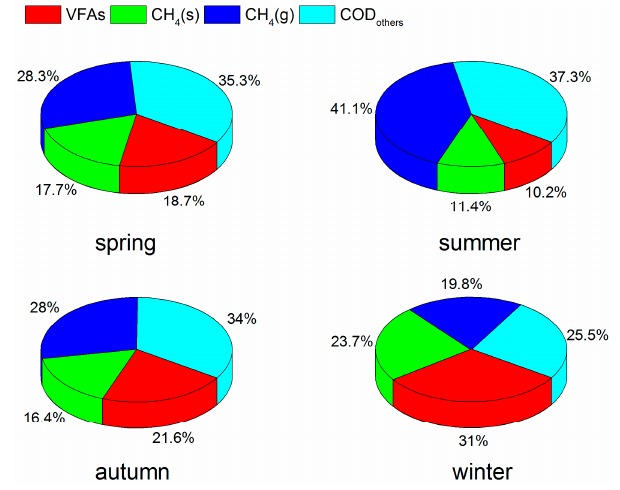
Figure 5. COD balance in different seasons.